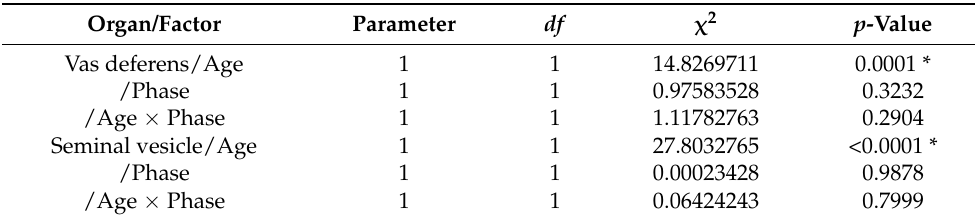
Table 2. The results of ordinary logistic regression analysis on the effects of phase variation and adult age on sperm distribution in the vas deferens and seminal vesicle of the desert locust Schistocerca gre- garia . Organ/Factor Parameter df χ 2 p -Value Vas deferens/Age 1 1 14.8269711 0.0001 * /Phase 1 1 0.97583528 0.3232 /Age × Phase 1 1 1.11782763 0.2904 Seminal vesicle/Age 1 1 27.8032765 <0.0001 * /Phase 1 1 0.00023428 0.9878 /Age × Phase 1 1 0.06424243 0.7999